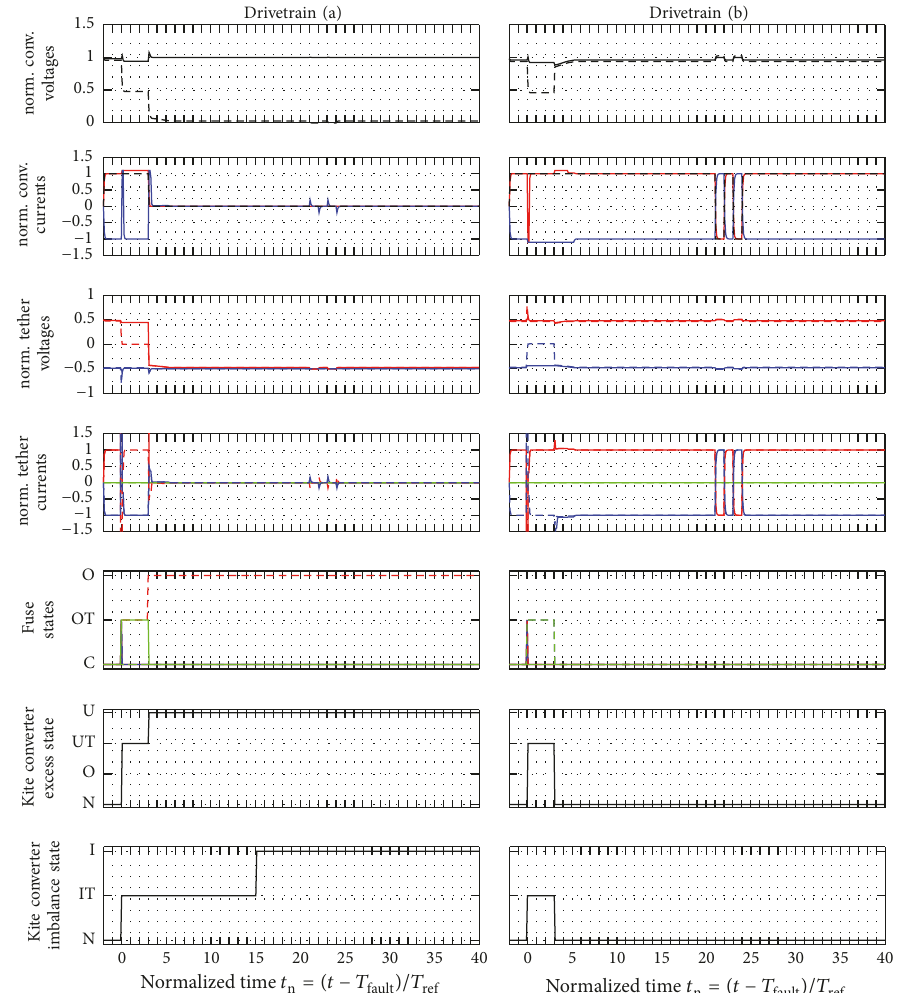
Figure 21: Simulated voltages, currents, and states for short circuit fault S7 in motor mode, with the same colors as in Figure 18.